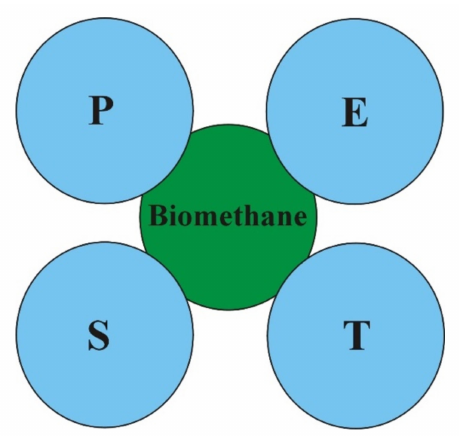
Macro-environment of the BM sector; P—political, E—economic, S—social, T— technological (the PEST